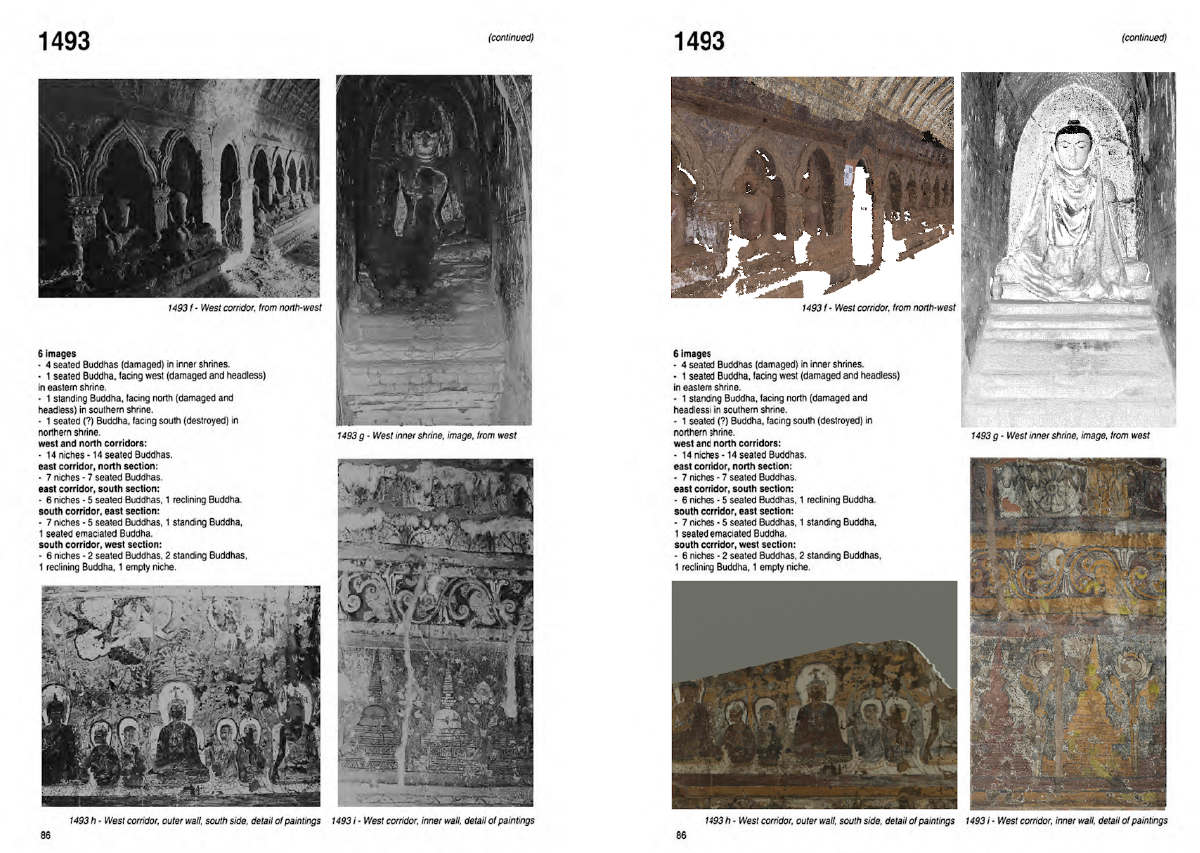
Figure 9. Comparison between Pierre Pichard report and 2018